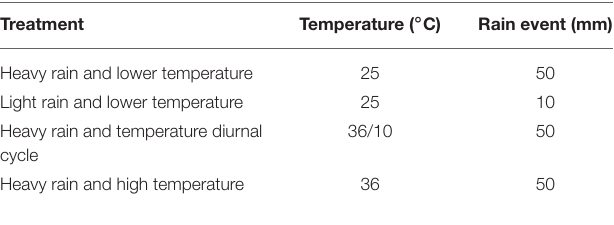
Frontiers in Microbiology |